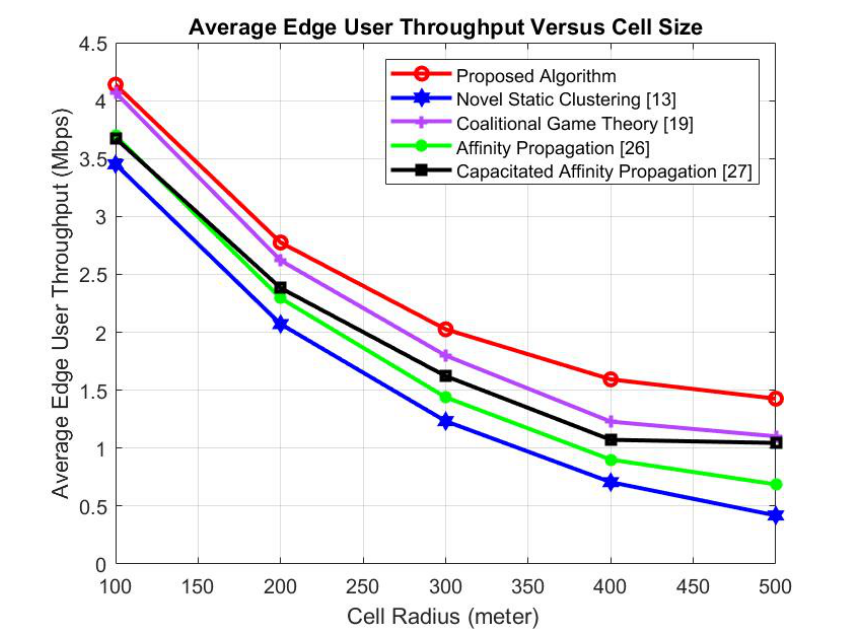
Figure 6. Average edge user throughput versus the cell